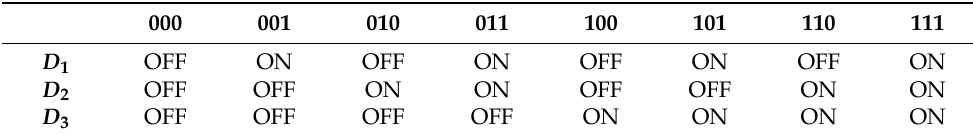
Table 1. Conditions of diodes in different states.